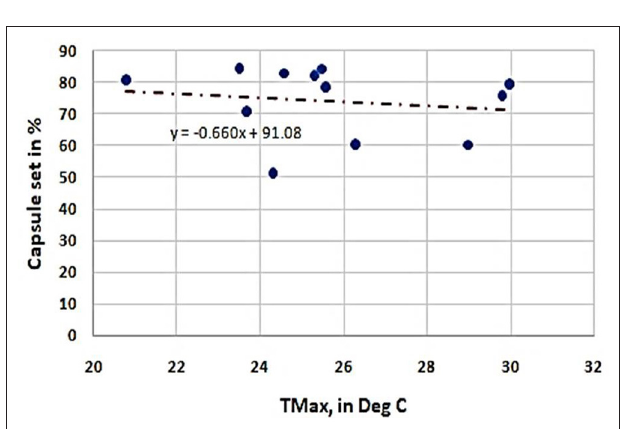
FIGURE 6 | Trend and influence of mean monthly temperature on cardamom capsule set (%).